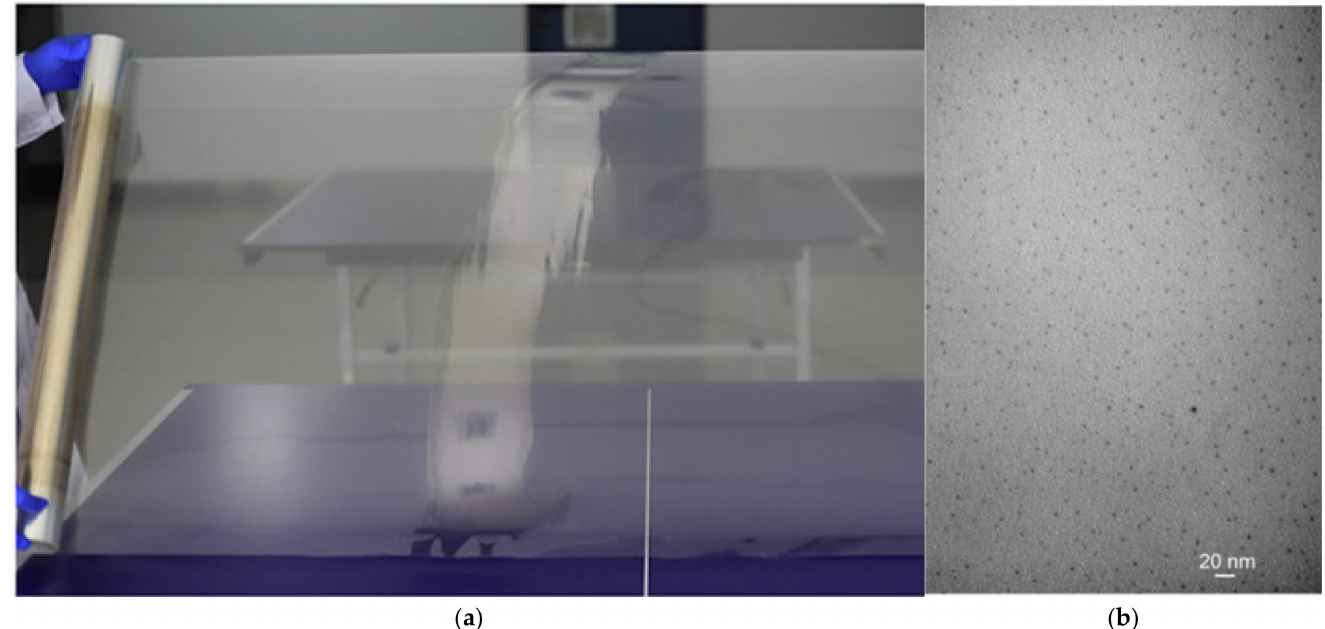
Figure 7. ( a ) Macroscopic morphology and ( b ) microscopic morphology of pilot-scale SPEEK mem- brane. (Reproduced from [160] with permission from